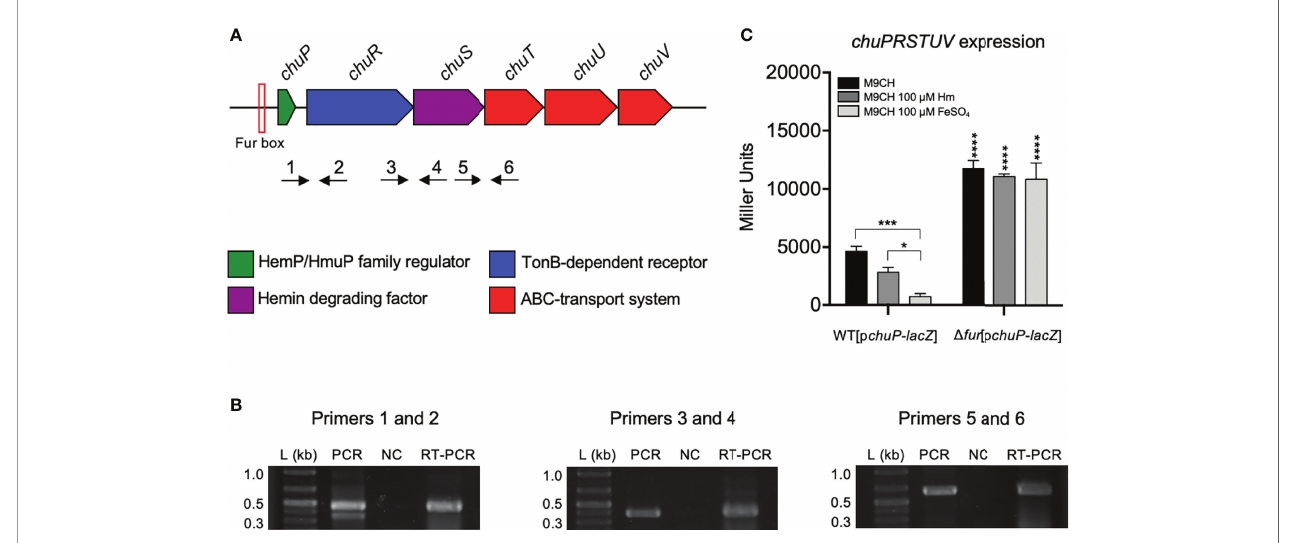
FIGURE 1 | The chuPRSTUV genes compose an operon regulated by the iron levels and Fur. (A) Genomic organization of the chuPRSTUV genes in C. violaceum . A predicted Fur box is indicated. Numbered arrows indicate the primers used in RT-PCR (not scaled). (B) Con fi rmation of co-transcription of the chuPRSTUV genes. The RT-PCR reactions ampli fi ed fragments of 439 bp (Primers 1 and 2), 373 bp (Primers 3 and 4), and 662 bp (Primers 5 and 6). Conventional PCR was performed using genomic DNA (PCR) and RNA (NC) as controls. L, 1 Kb plus DNA Ladder (Thermo Scienti fi c). (C) Promoter activity of the chu operon in response to iron and Fur. b -galactosidase assays were performed from the WT and D fur strains harboring the chuP-lacZ fusion grown in M9CH medium and either untreated or treated with 100 m M Hm or 100 m M FeSO 4 . Data are from three biological replicates. ****p < 0.0001; ***p < 0.001; *p < 0.05; when not indicated, not signi fi cant. Two-way ANOVA followed by Dunnett ’ s multiple-comparison